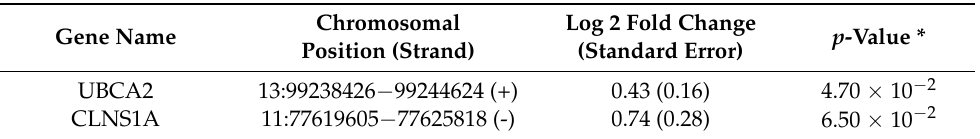
Table 5. The most differentially abundant circRNA transcript fragments in plasma from patients compared with